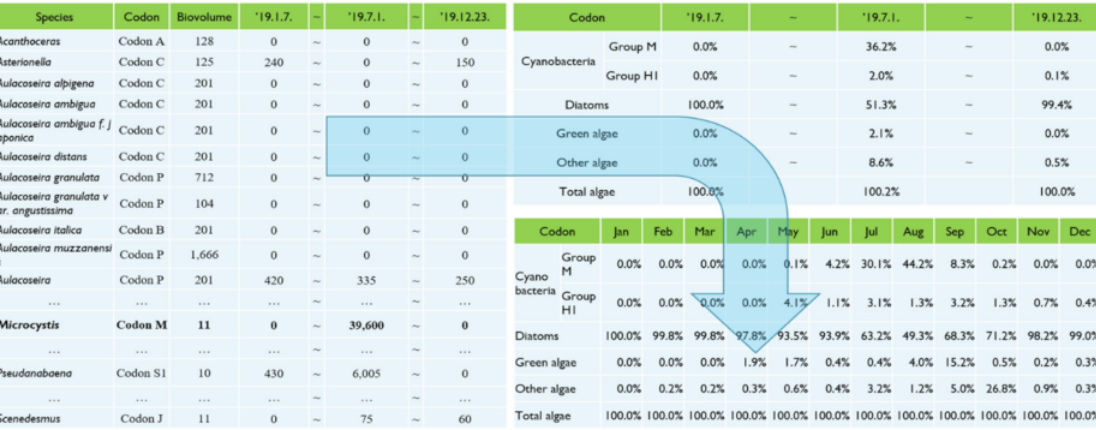
Figure 3. Procedure for calculating monthly carbon occupancy proportions of each algal group